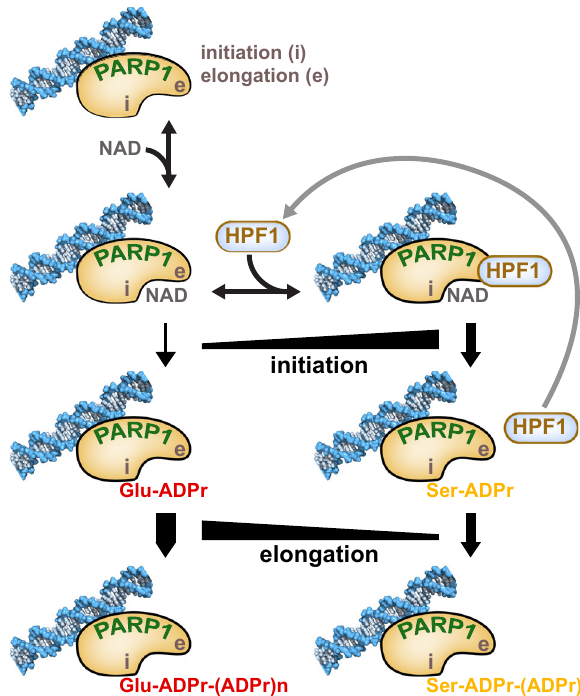
Fig. 8 Model for HPF1 regulation of PARP1/2 catalytic output. HPF1 regulates the balance between initiation (i) and elongation (e) through a dynamic interaction with the catalytic domain and by accelerating the rate of initiation on Ser residues. Rapid HPF1 cycling between PARP1 molecules, indicated by the long arrow, allows the PARP1 population to be ef fi ciently modi fi ed on Ser, and also prevents excessive inhibition of the elongation reaction to form PAR that is important for DNA damage